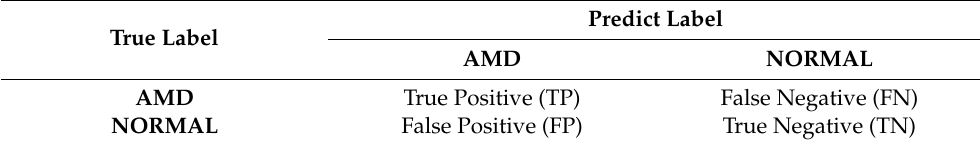
Table 2. Binary-classification confusion matrix. True Label